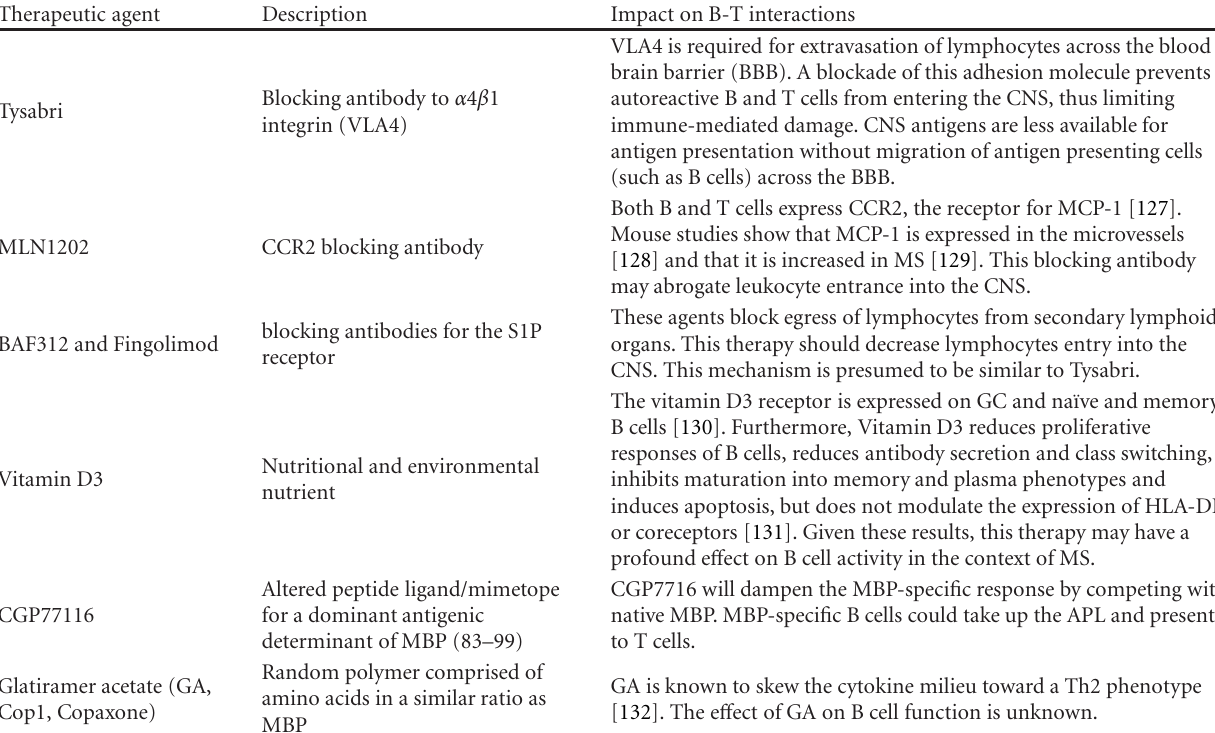
Table 2: Possible impact of established and emerging therapies for MS on B cell